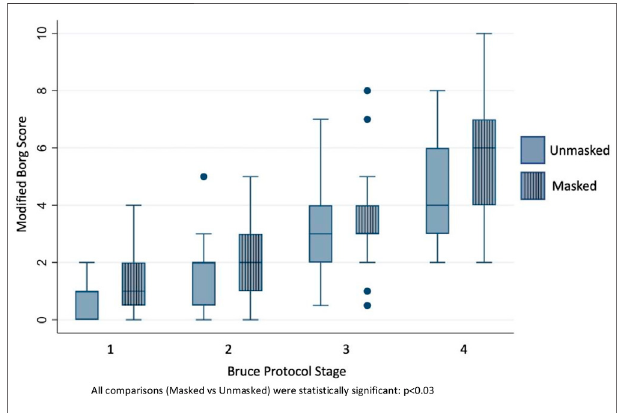
FIGURE 1 | Modi fi ed Borg scores at respective Bruce stages of unmasked vs. masked exercise treadmill test.